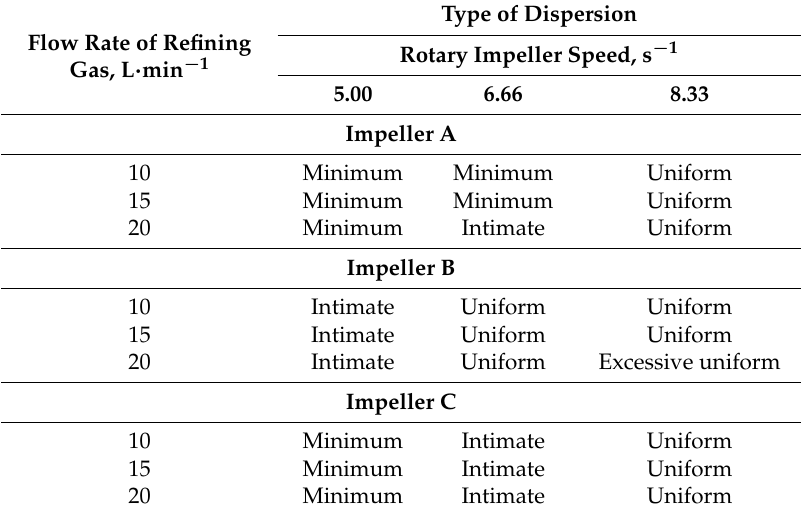
Table 3. Summary of visualization results—different types of gas bubble dispersion in water, for flow rate of refining gas in range: 10–20 L · min − 1 , and rotary impeller speed: 5.00–8.33 s − 1 , for three studied rotary